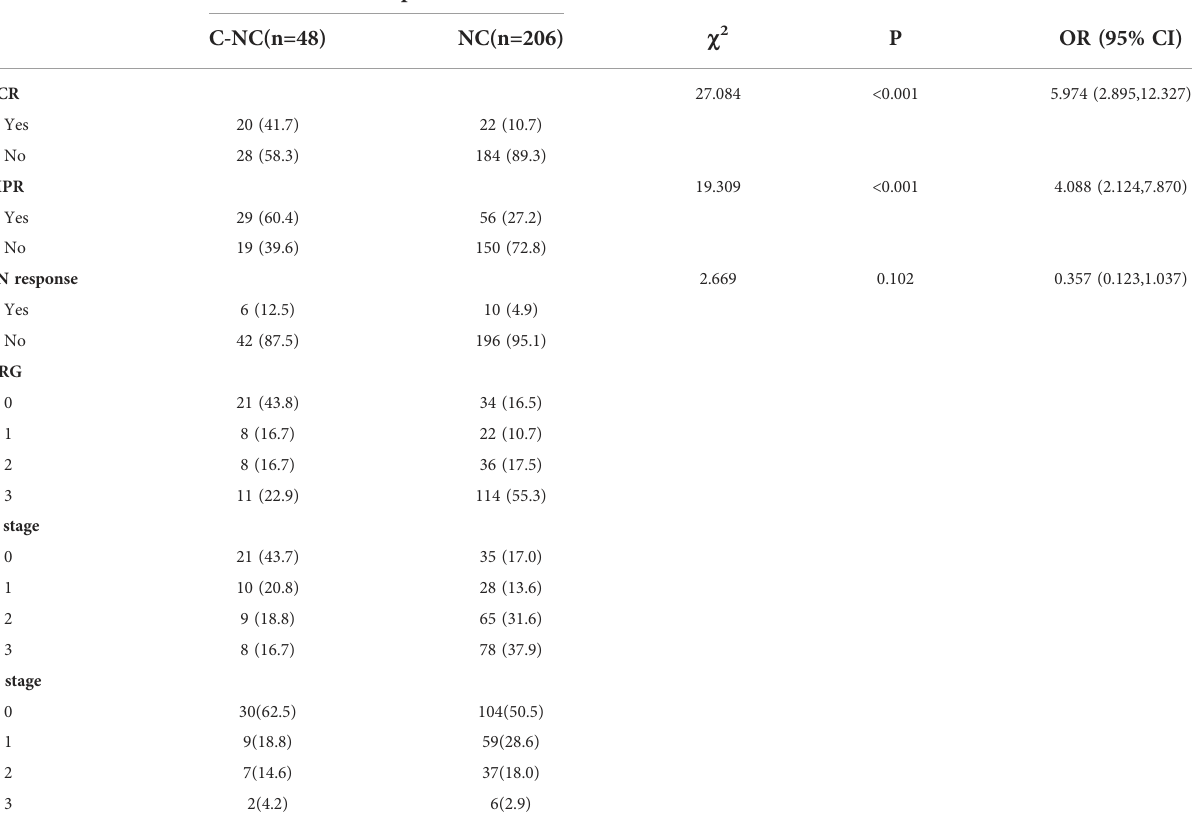
TABLE 3 Postoperative pathology of patients with